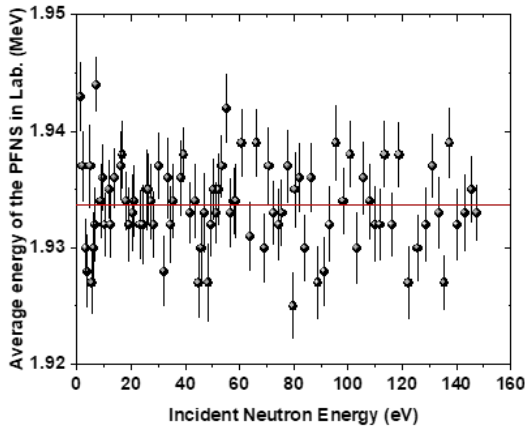
Figure 7. Average energy of the prompt neutron energy spectra calculated with FIFRELIN for the 88 resonances, as a function of the incident neutron